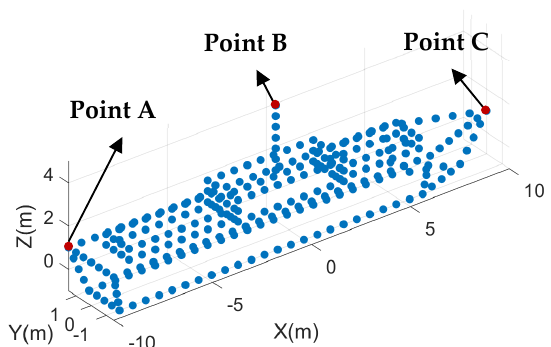
Figure 21. Ship point-array model with a size of 20 m × 3 m × 4 m.